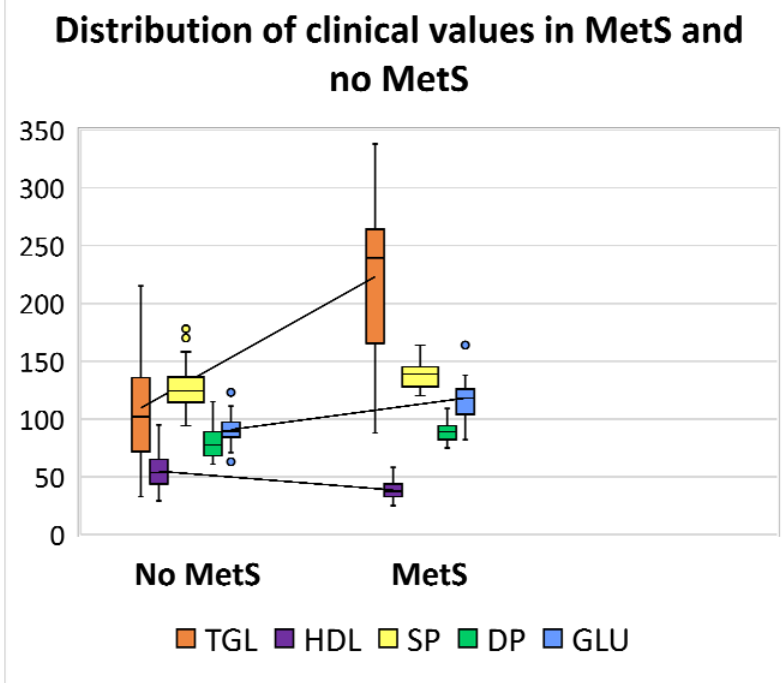
Figure 1. Box and whisker plot showing the distribution of clinical values levels in patients with MetS and no MetS. The line located in the middle of the box represents the median and is used to better visualise the differences between clinical parameters: triglycerides (TGL) levels are displayed in orange ( ); high density lipoprotein (HDL) in violet ( ); systolic pressure (SP) in yellow ( ); di ‐ astolic pressure (DP) in green ( ); and glucose (GLU) in blue ( ). Table 1. The distribution of the clinically measured parameters in MetS and no MetS patients ex ‐ pressed in mg/dL and in mmHg.